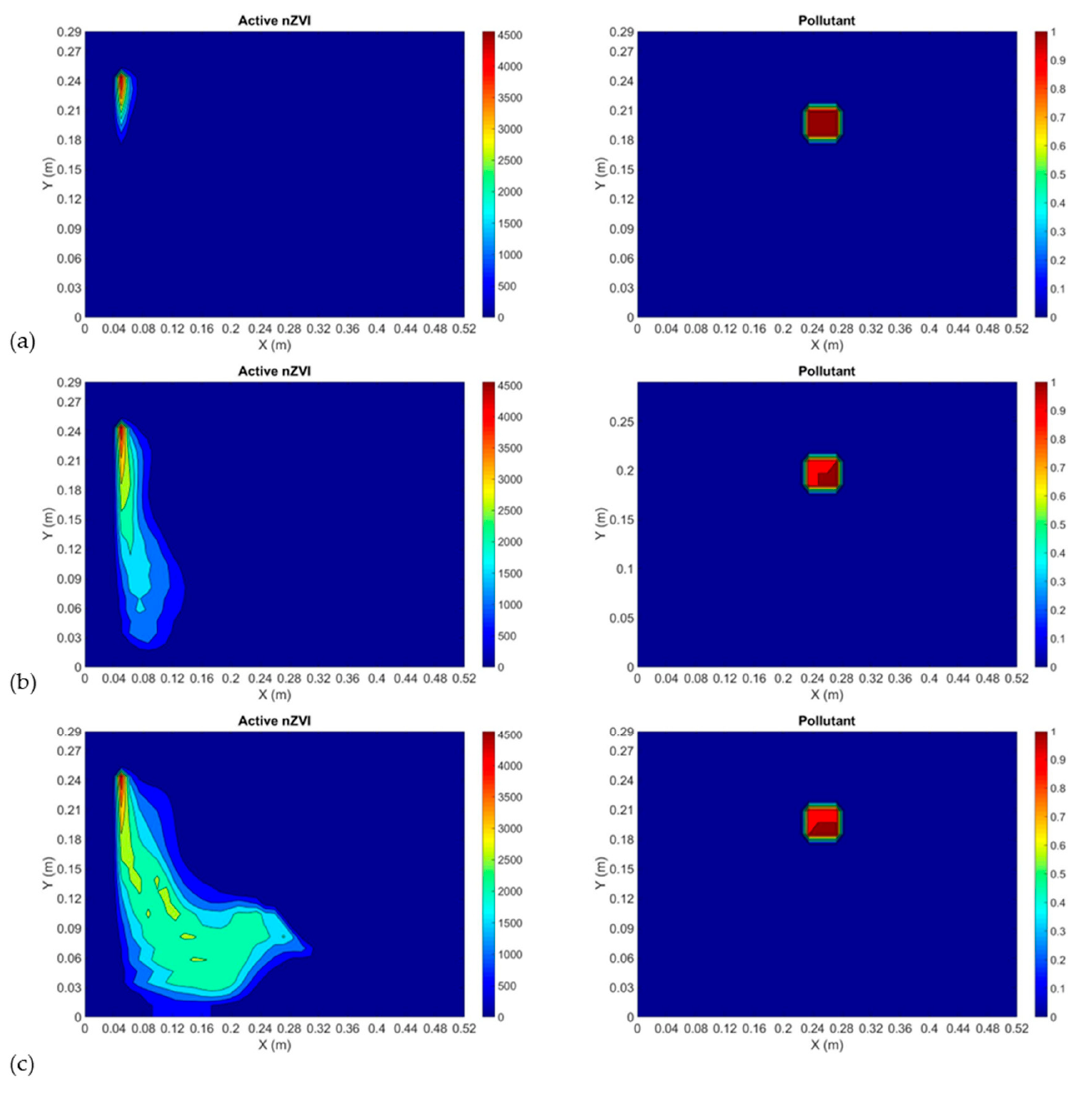
Figure 8. Numerical simulation of nanoparticles redistribution and contaminant removal in a hetero- geneous aquifer at time = 46 s ( a ), time = 2 min 11 s ( b ) and time = 2 min 50 s ( c ). The injection of nanoparticles was simulated near the border of the domain .